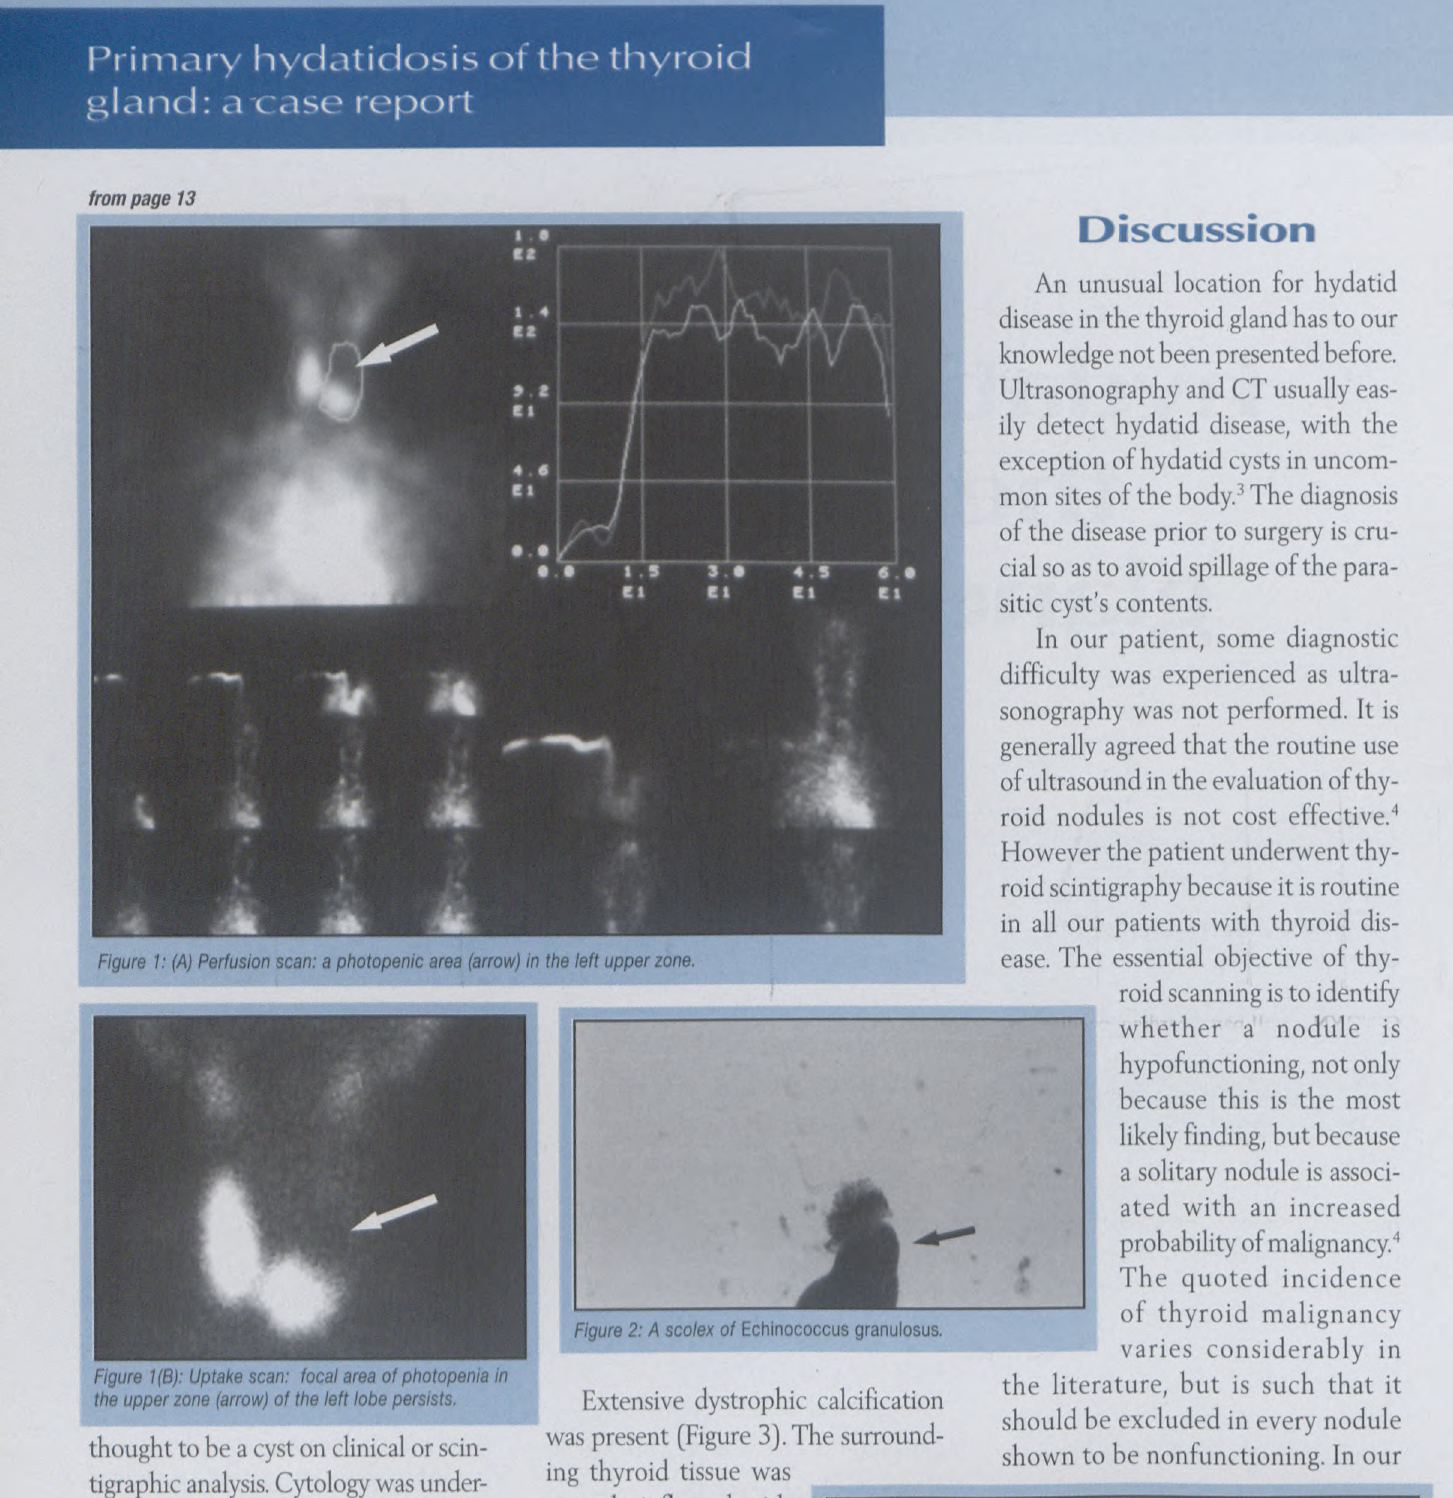
Figure 1 (B): Uptake scan: focal area of photopenla in the upper zone (arrow) of the left lobe persists.